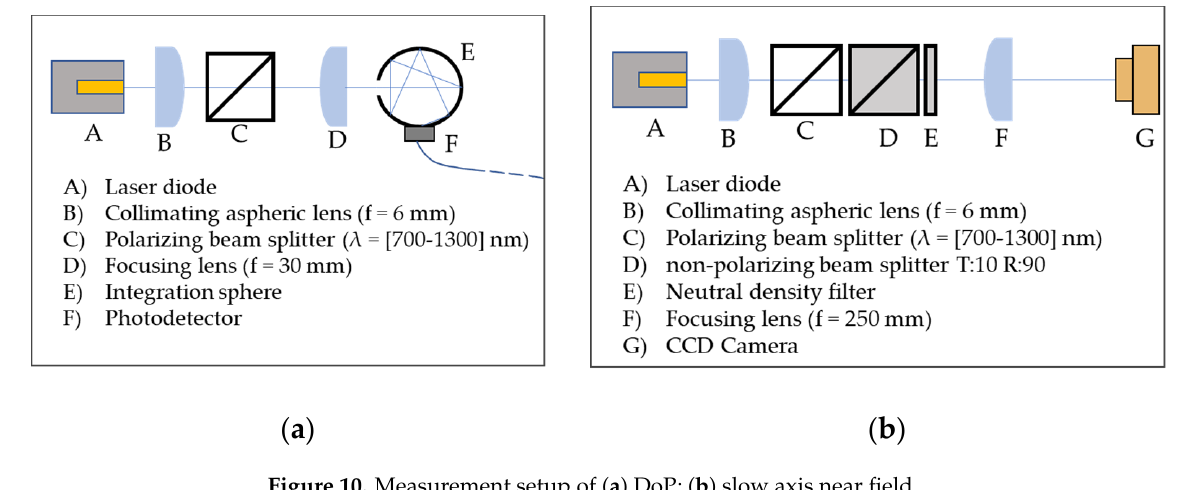
Figure 11. Measurement of 324 mounted HPLD: ( a ) TM-polarized NFSA; ( b ) TE-polarized NFSA . For mainly TE-polarized compressively strained-QW HPLD, the TM-polarized NFSA represents a distribution of the mechanical stress on the device and can be very useful in the development of high-DoP HPDL, by optimizing chip dielectrics, metals, shape, mounting process, and carrier structure. Given that mechanical stress is an effect of the randomly changing technological conditions within a statistical process control, a